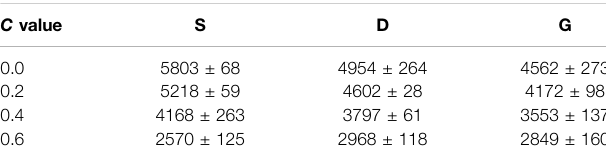
TABLE 3 | Elastic modulus measured experimentally of the different porous scaffolds ( n = 3, MPa). C value